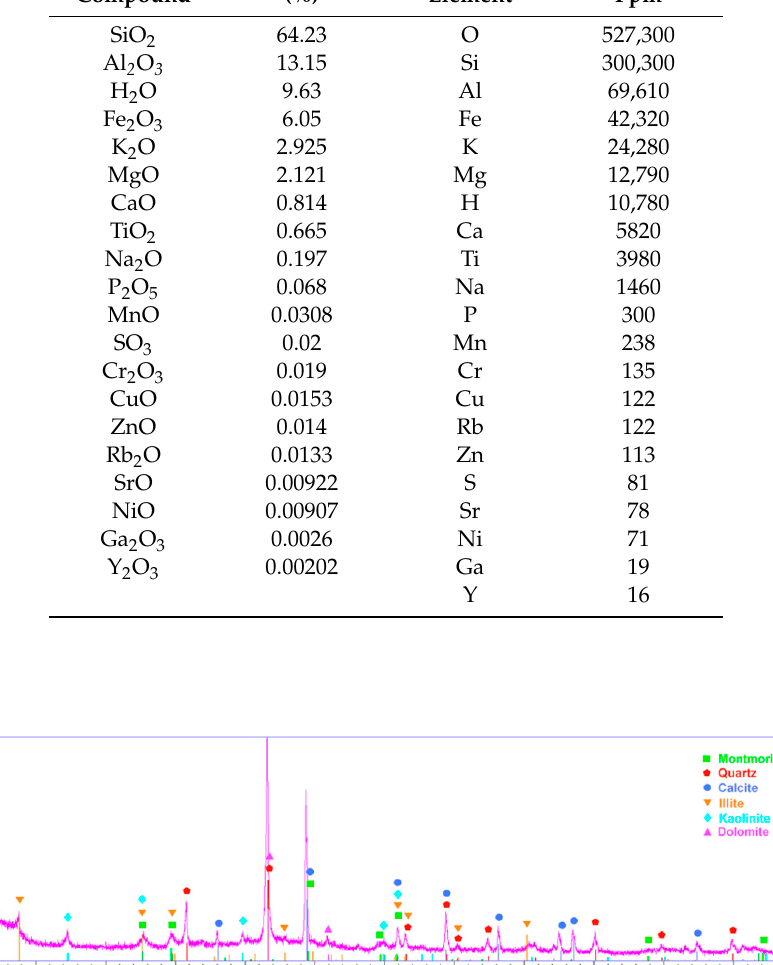
Table 2. Concentrations (in % and ppm) of the major and minor elements identified in the XRF analysis. The table represents mean values on XRF tests that have been performed on seven samples.